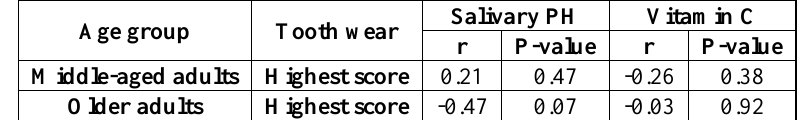
Table 5: Relation of the highest score of tooth wear (by Subjects) with salivary pH and vitamin C level by age